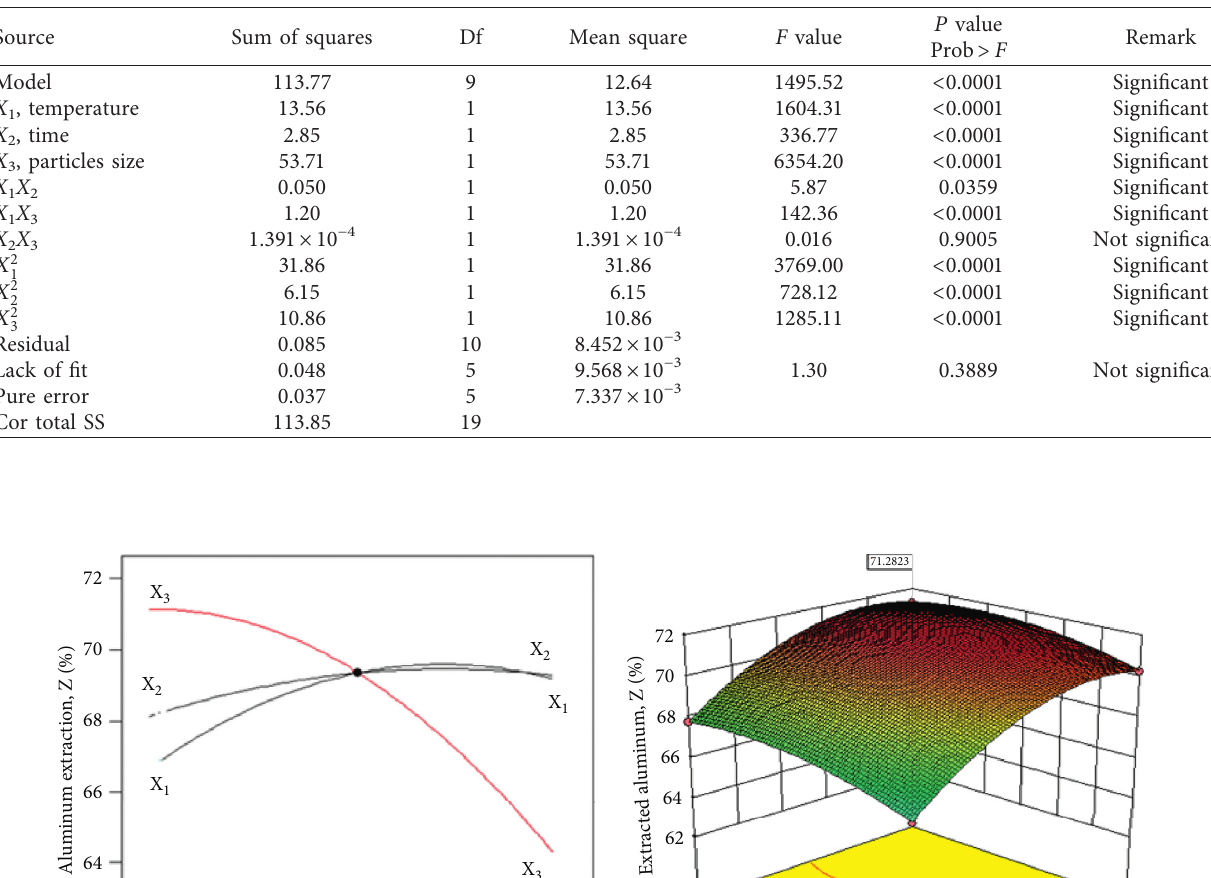
Table 7: ANOVA for the surface quadratic model (response: extracted